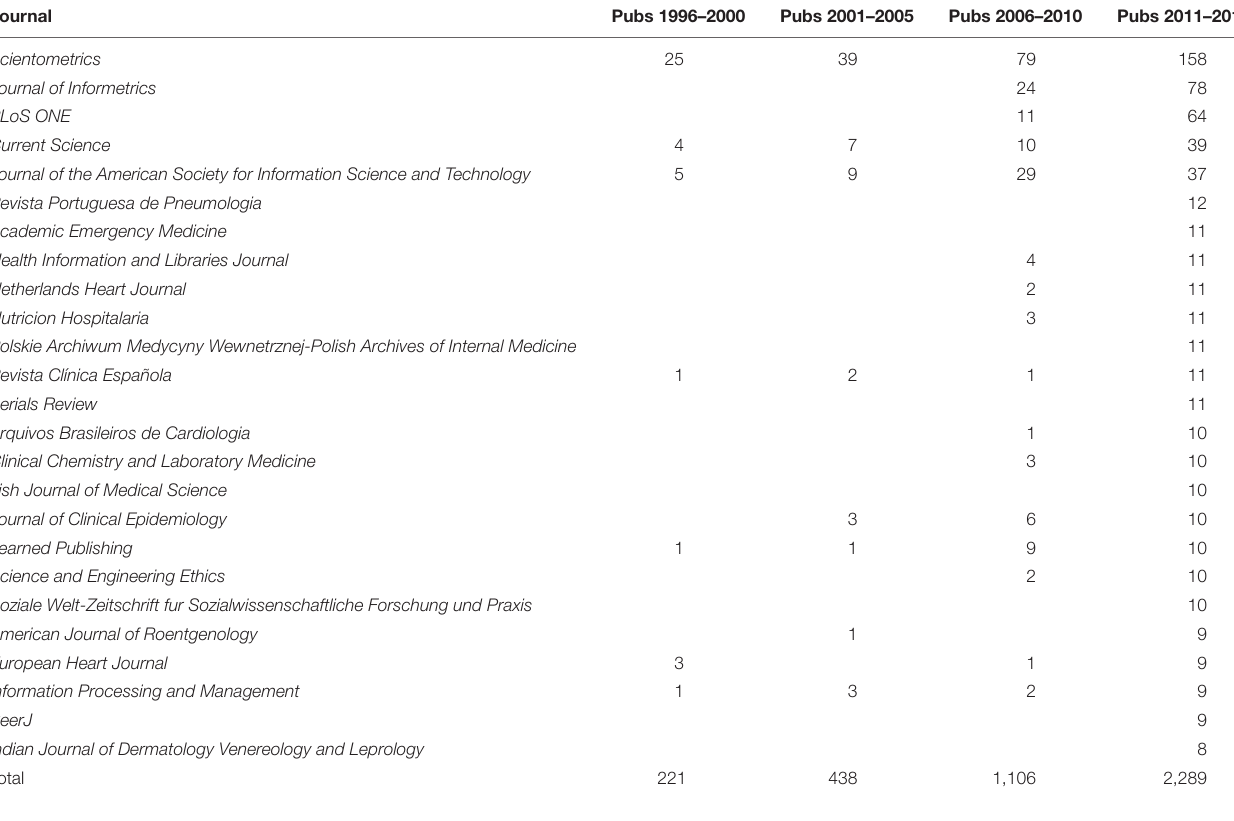
TaBle 1 | Output numbers across journals in Wos on Journal impact Factors, 1996–2015.